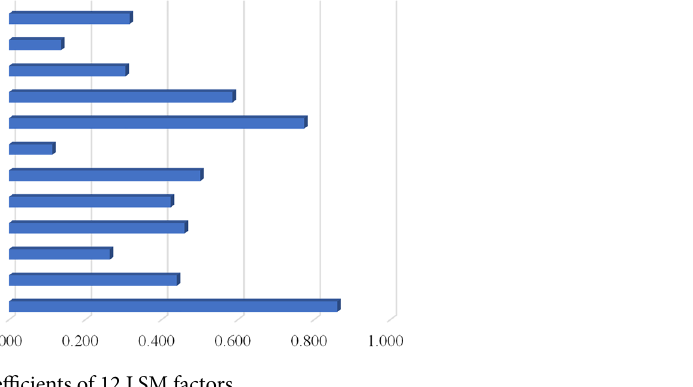
Figure 9. Relief-F coefficients of 12 LSM factors.